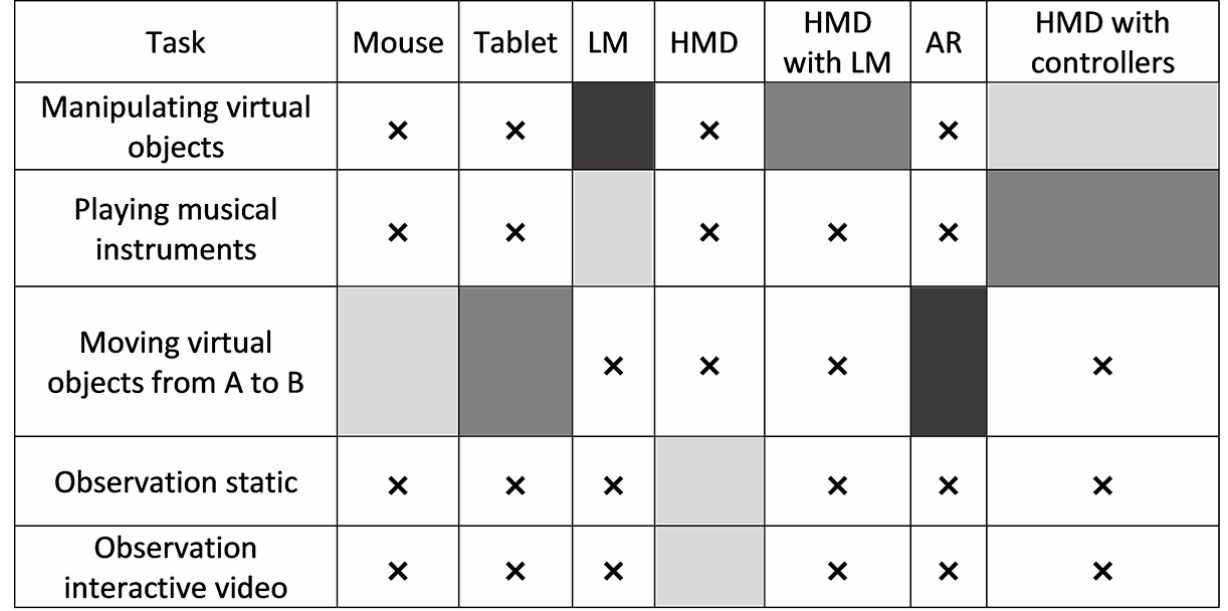
Figure 12. Suitable technologies for each task. Grayscale intensity represents the total number of issues (the lower the intensity, the lower the number of errors), and x represents technologies that have not been used to perform that given task. LM: leap motion; HMD: head-mounted display; AR: augmented